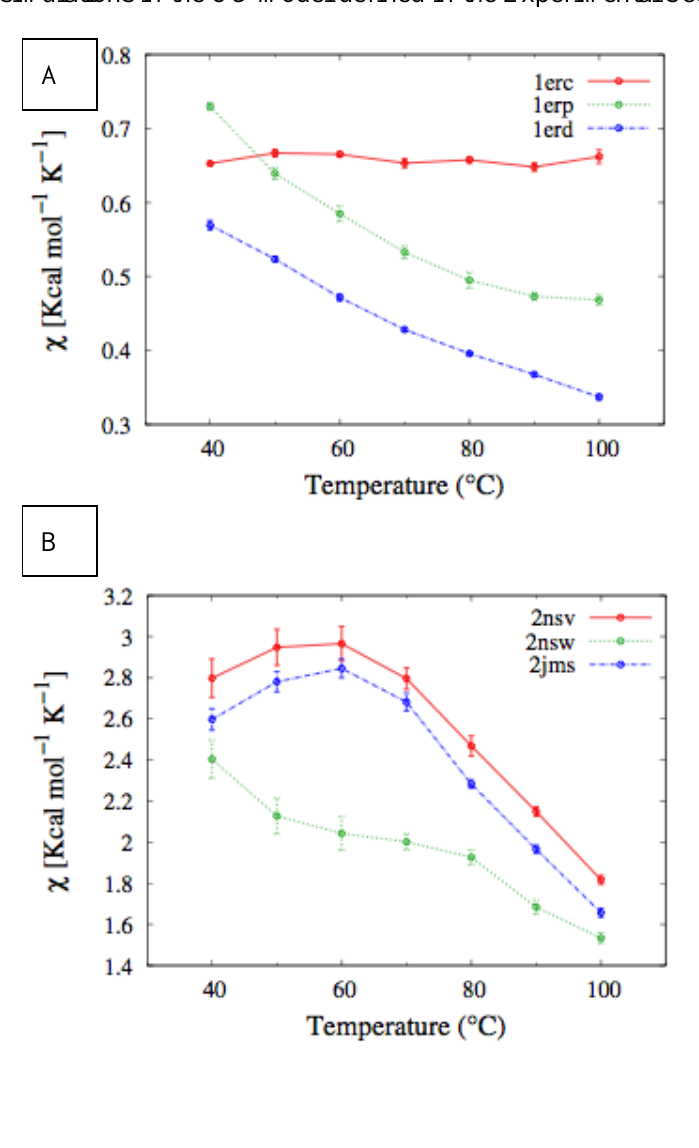
Figure 4. Comparison of the temperature-dependence of the fluctuation of fraction of native contacts defined in Equation (1) for different E r ( A ) and E n ( B ) pheromones obtained by means of MC simulations in the CG model defined in the Experimental